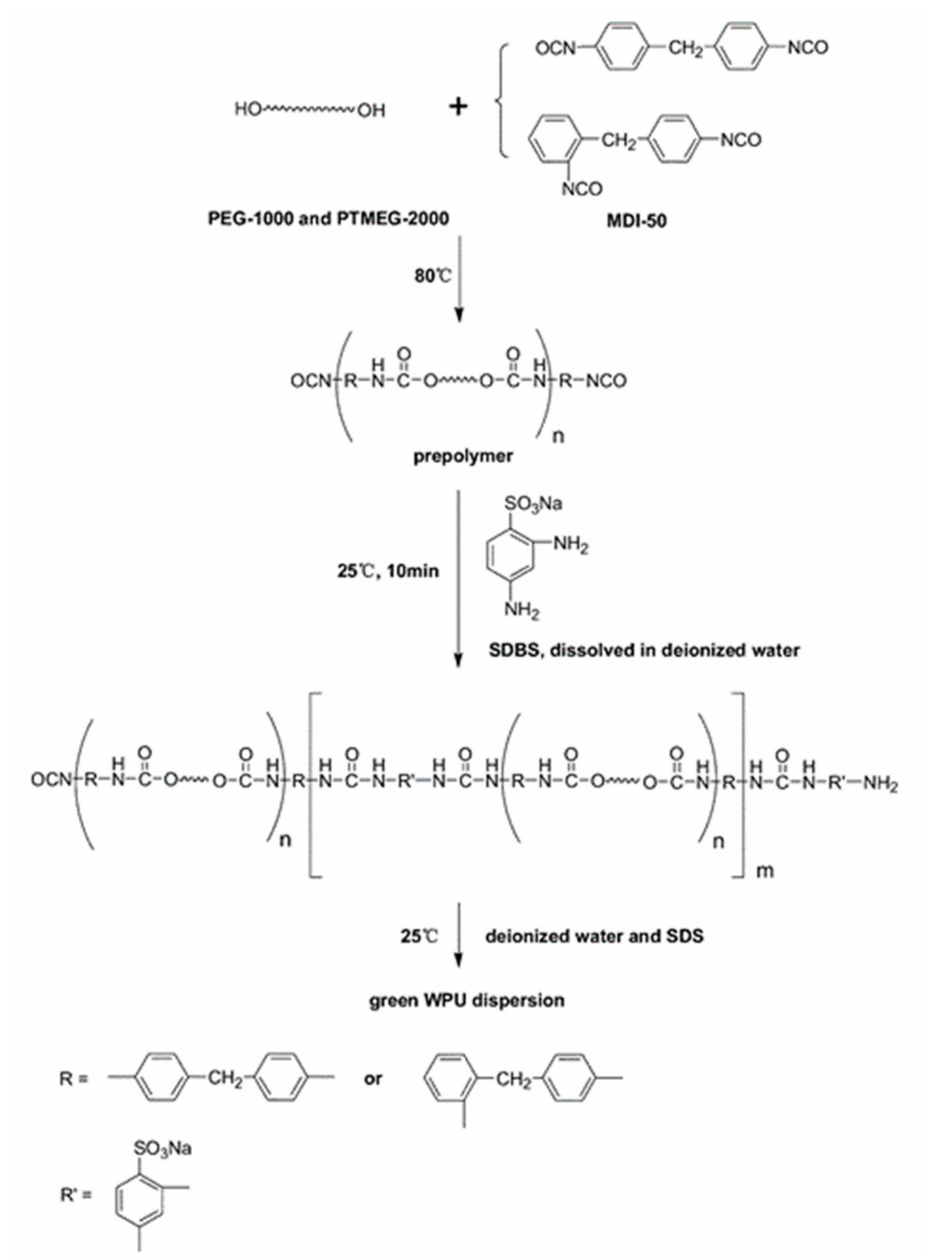
Figure 3. Schematic diagram of synthesis process of aqueous polyurethane dispersions [16]. Copyright © (2016)